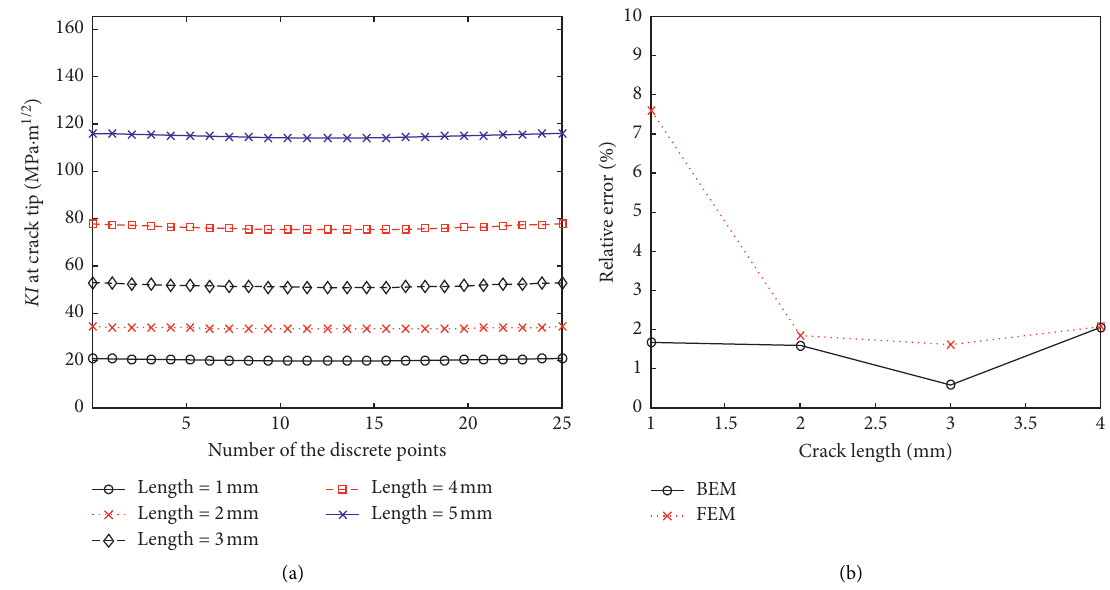
Figure 8: KI values at the crack tip. (a) Relations between discrete points and KI . (b) Relative error comparisons between the FEM and the BEM.